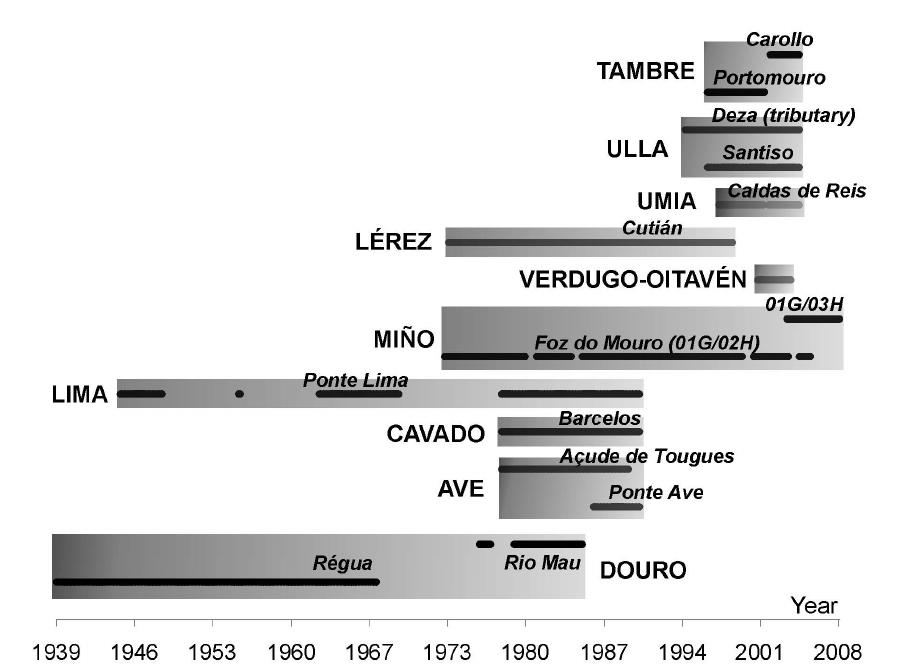
Fig . 2. – Available stream flow data (solid lines) from 1939 to 2008 for all rivers. Shaded regions are periods with runoff estimation in the river